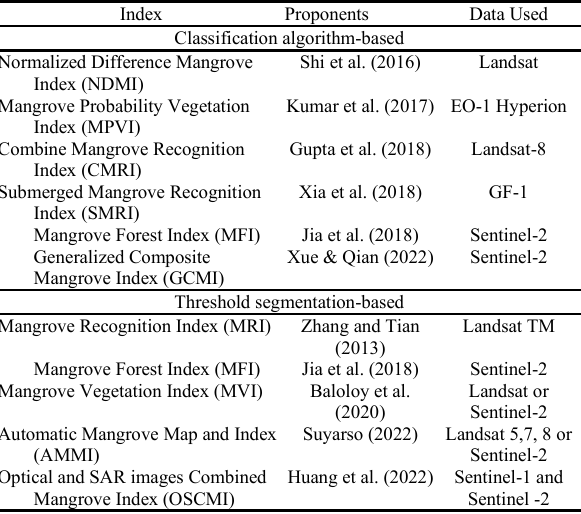
Table 1. Indices for Mangrove Mapping